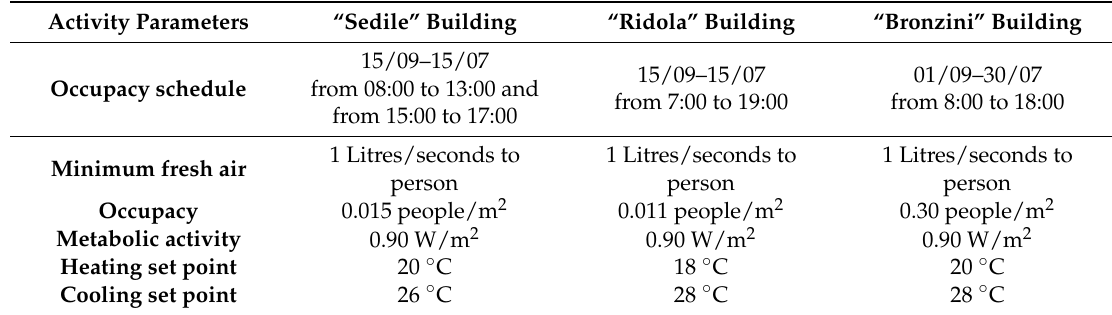
Table 5. Activity parameters.